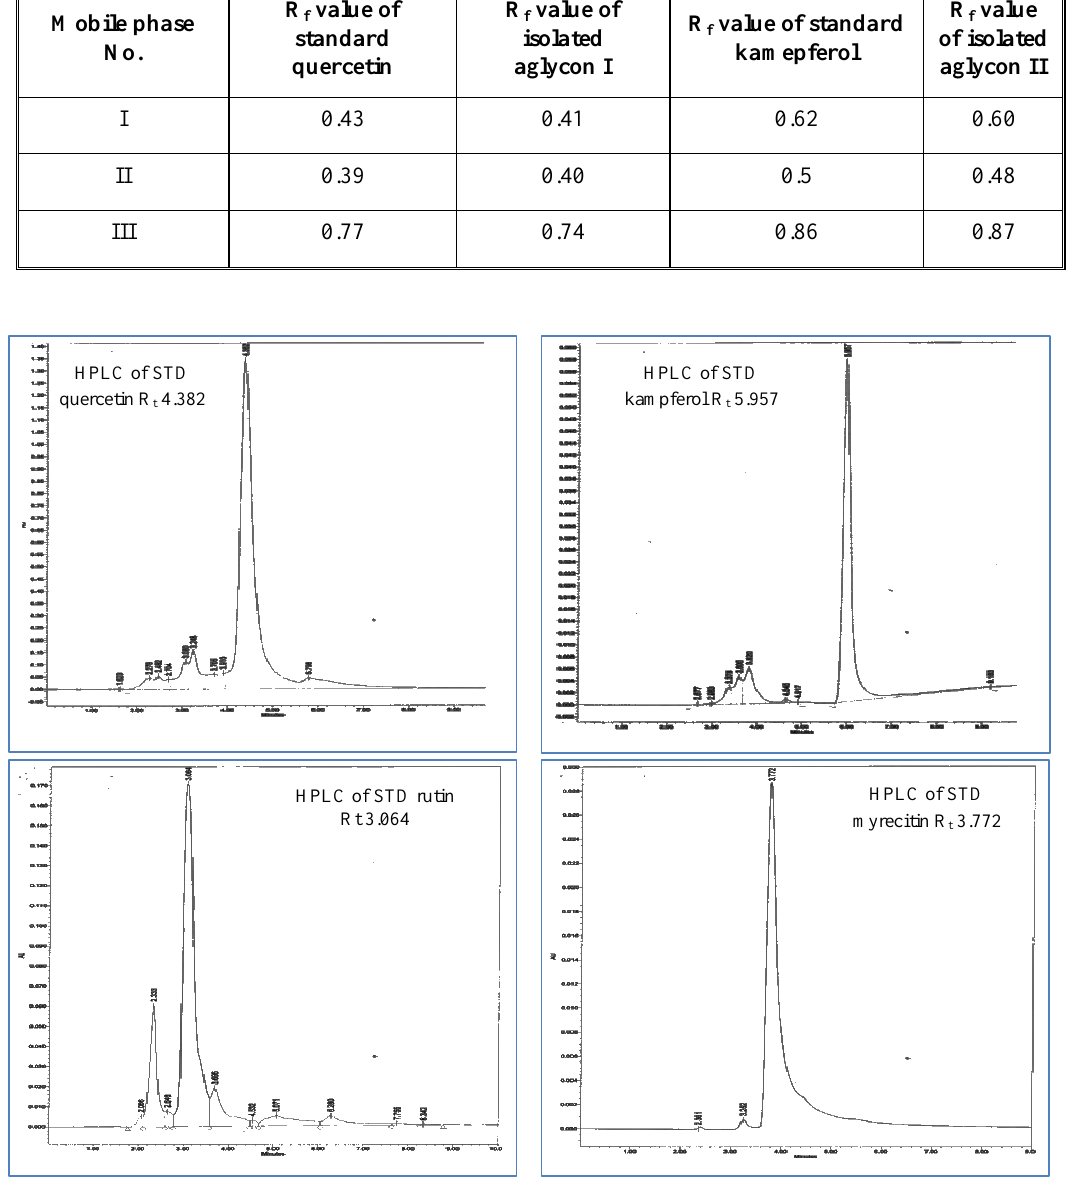
Figure (1):- HPLC of standards quercetin, kampferol, rutin and myrecitin Detection of rutin the presence of rutin in n-butanol fraction was detected by HPLC and TLC. HPLC chromatogram of standard rutin is shown in figure 1 TLC of n- butanol fraction compared with standard rutin results are shown in table(2).